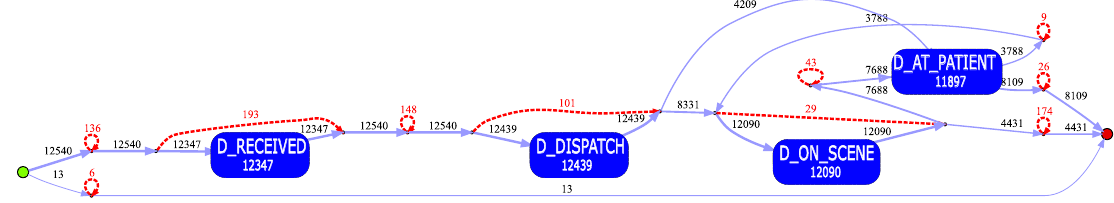
Figure 5. Process model of Cohort 1—no transport.